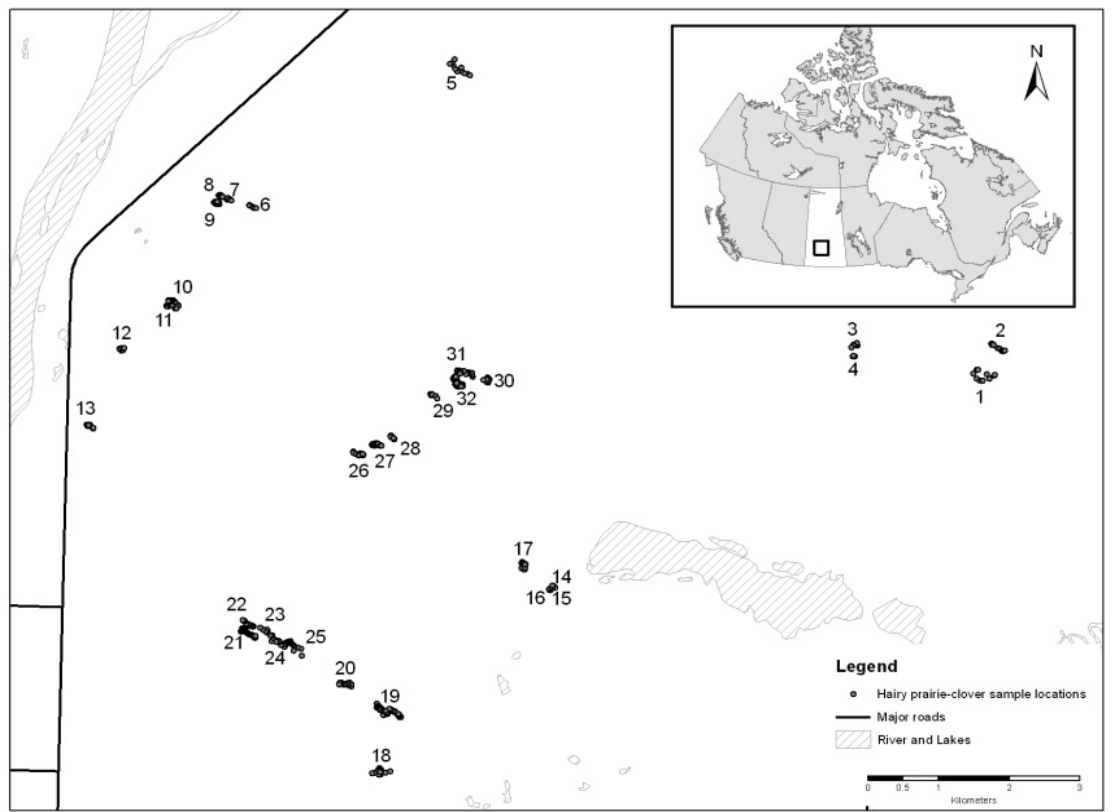
Figure 1. Location of the remnant population of hairy prairie-clover in the Canadian Prairie and distribution of 32 defined patches with clear boundary and